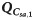
The five-element lumped model of the arterial system.pao, aortic pressure; Qao, aortic flowrate; psv, systemic venous pressure; Rsa,0, characteristic systemic resistance; Rsa, systemic arterial resistance; Lsa, systemic arterial inertance; Csa,1 and Csa,2, two components of the arterial compliance; QCsa,1 and QCsa,2, flowrates through the two compliances; psa, pressure before pressure drop of the systemic arterial resistance.